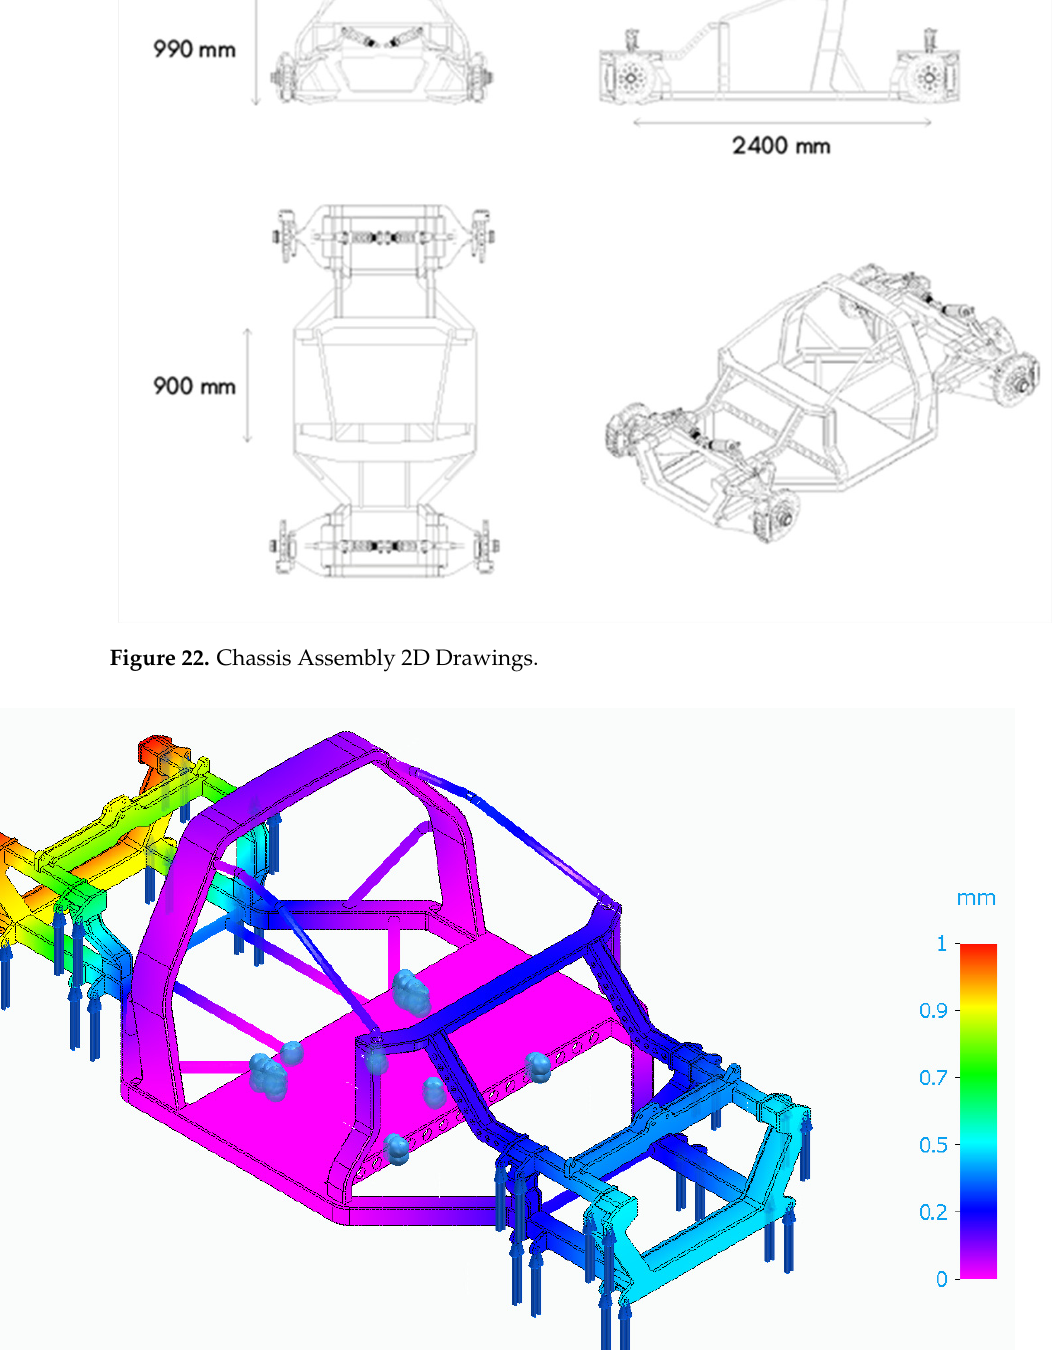
Figure 24. FEM Analysis with 6000 N load and 3 mm deformation.